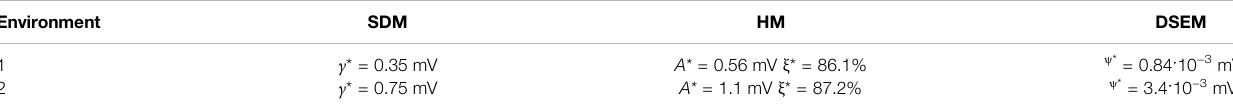
TABLE 2 | Detection thresholds achieved for each environment and strategy. Environment